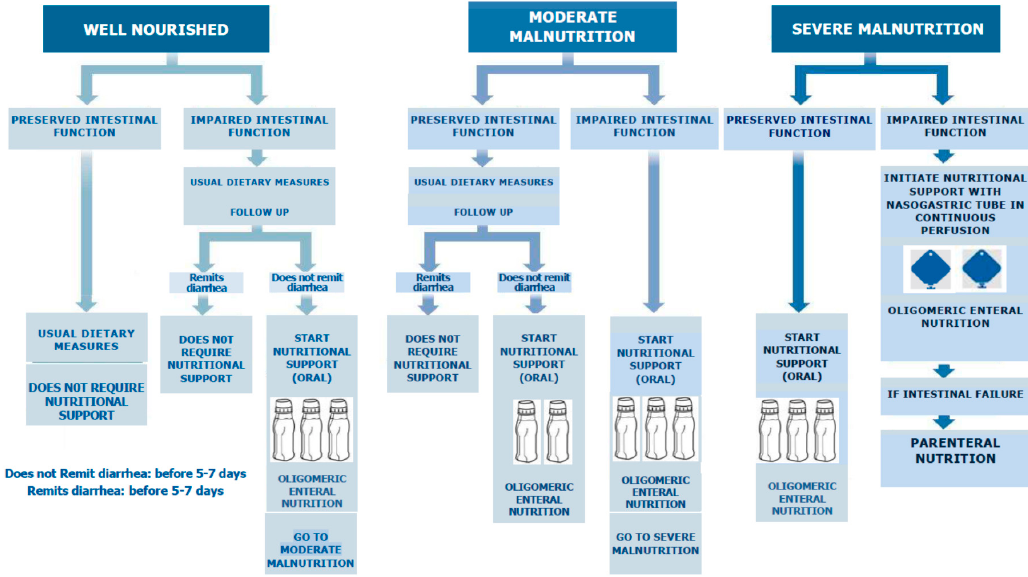
Figure 2. Nutritional support algorithm in patients with Oncology treatment-related diarrhea.